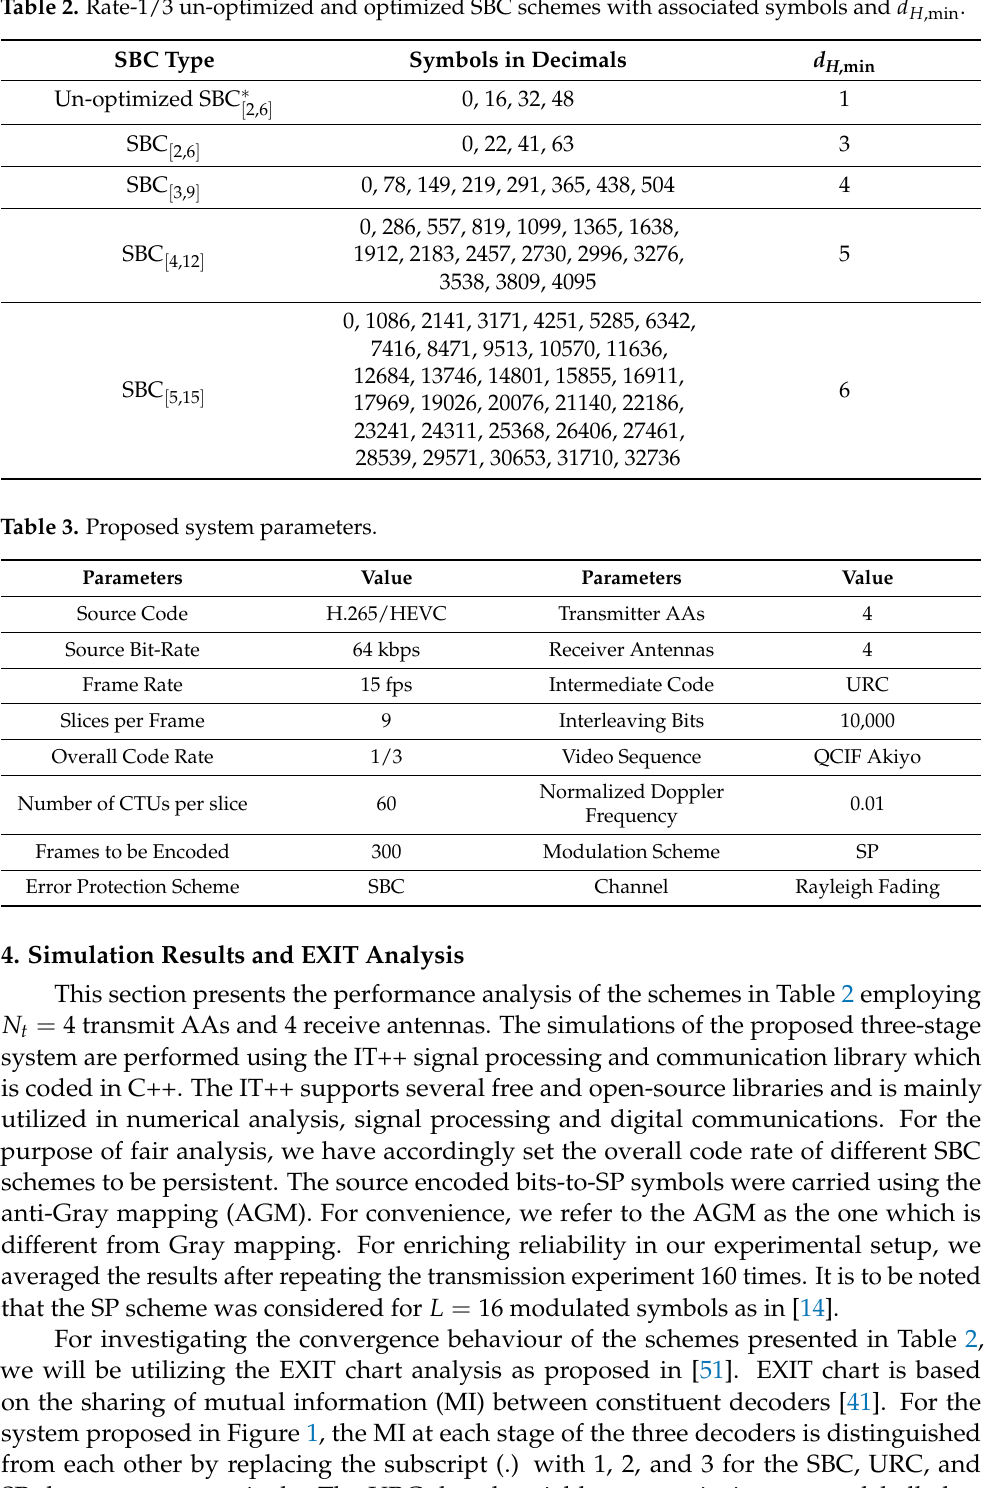
Table 2. Rate-1/3 un-optimized and optimized SBC schemes with associated symbols and d H ,min .